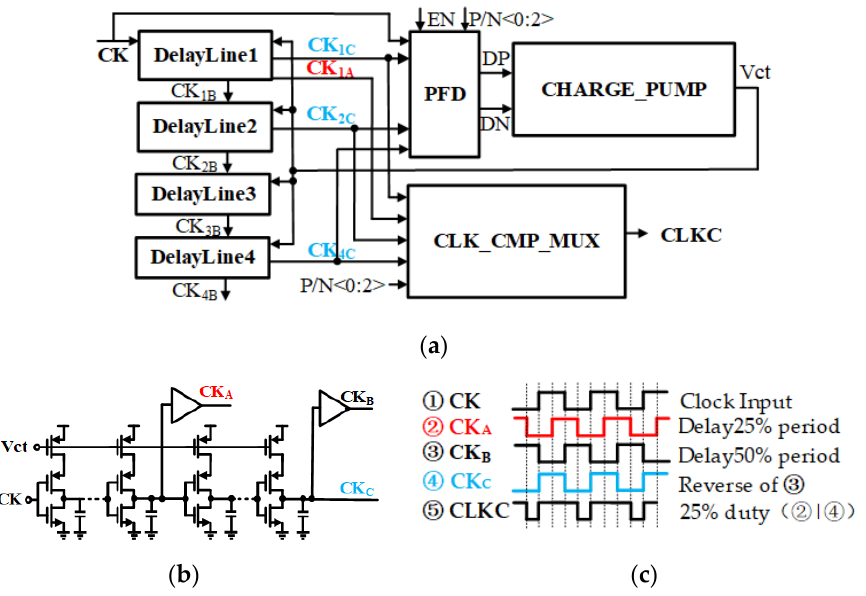
Figure 5. Delay lock loop. ( a ) Delay lock loop schematic; ( b ) Delay line schematic; ( c ) timing of delay line.